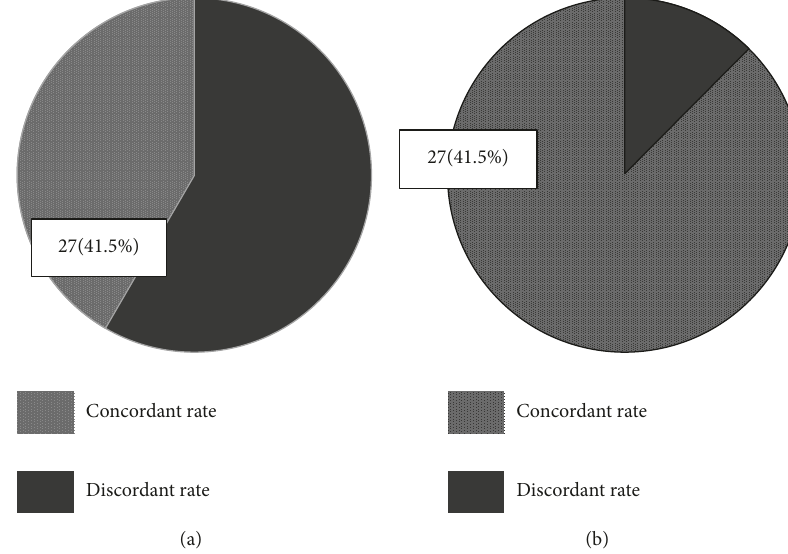
Figure 1: Concordance rate between WFO and the GMDT at (a) the recommended level and (b) the for consideration level. Treatment concordance between WFO and GMDT; (a) concordance of level of “recommended”; (a) concordant rate between WFO and GMDT (recommended); (b) concordant rate between WFO and GMDT (for